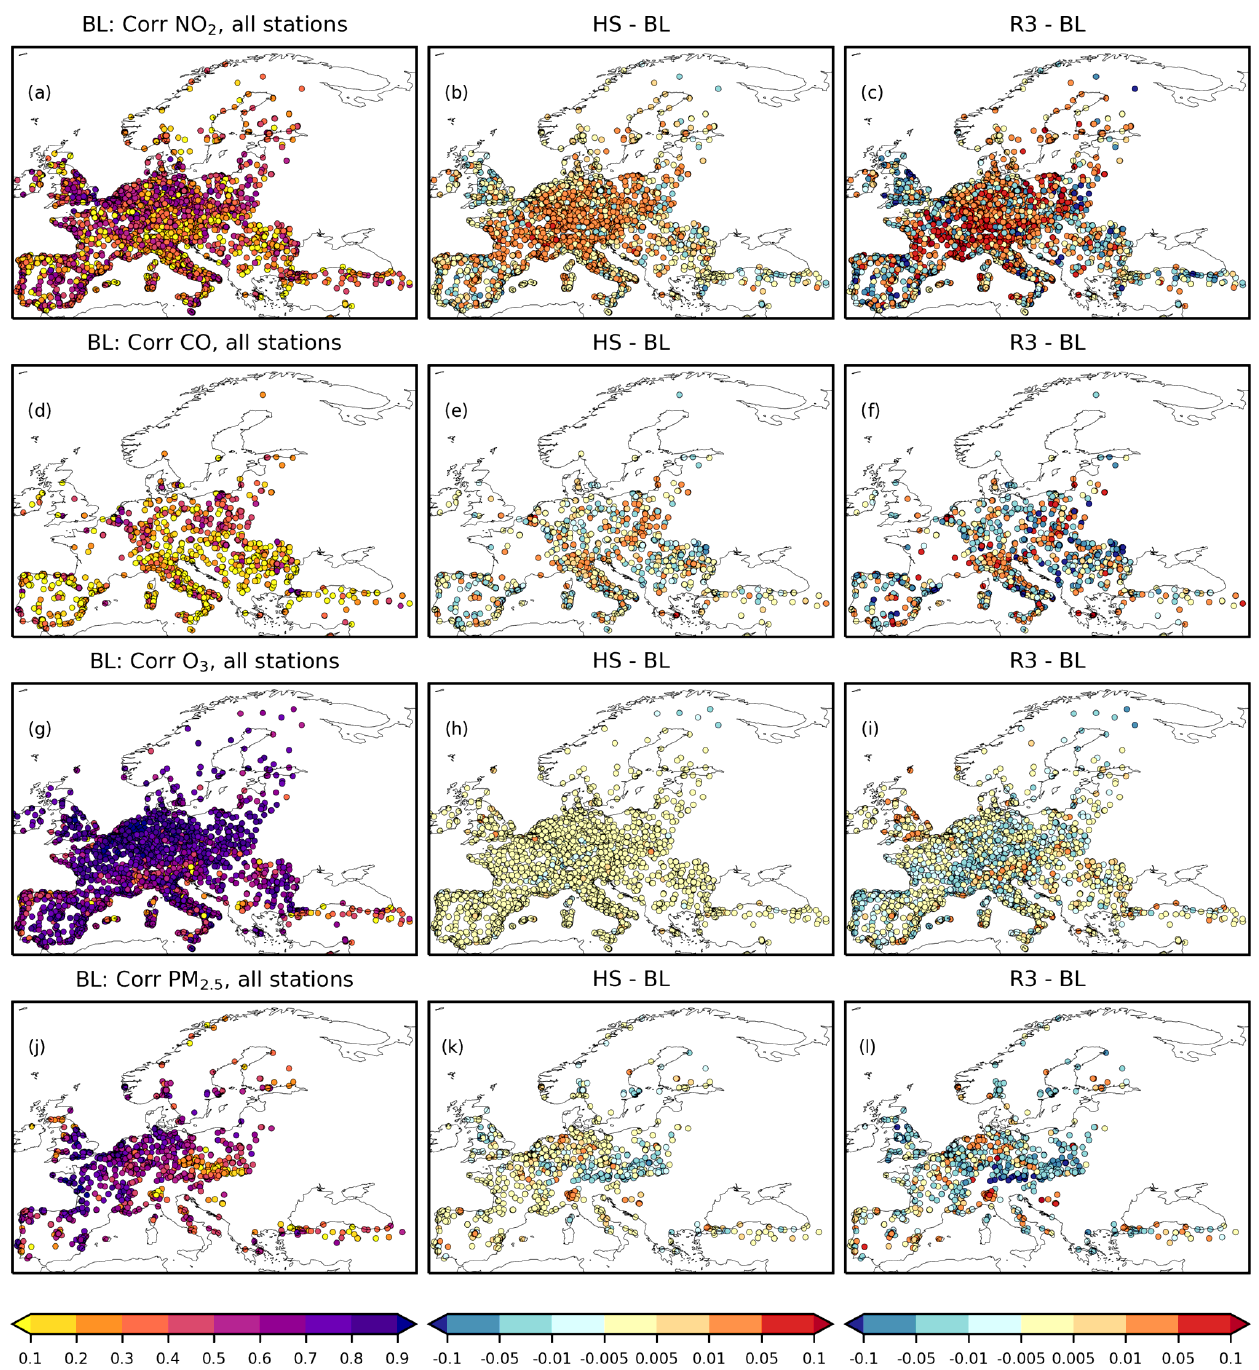
Figure 8. Maps of the temporal correlation coefficient of hourly NO 2 , CO, O 3 , and PM 2 . 5 concentrations for the EEA stations during